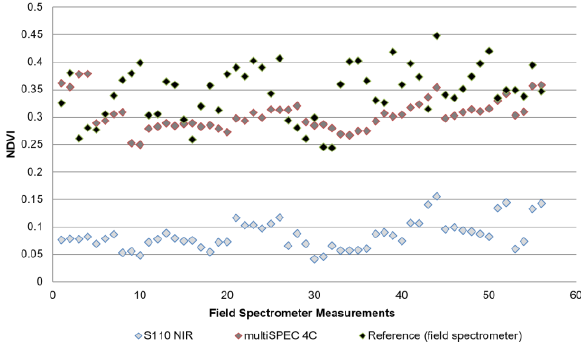
Figure 8. NDVI values of the multiSPEC 4C prototype, S110 NIR and field spectrometer for identical rape test plots